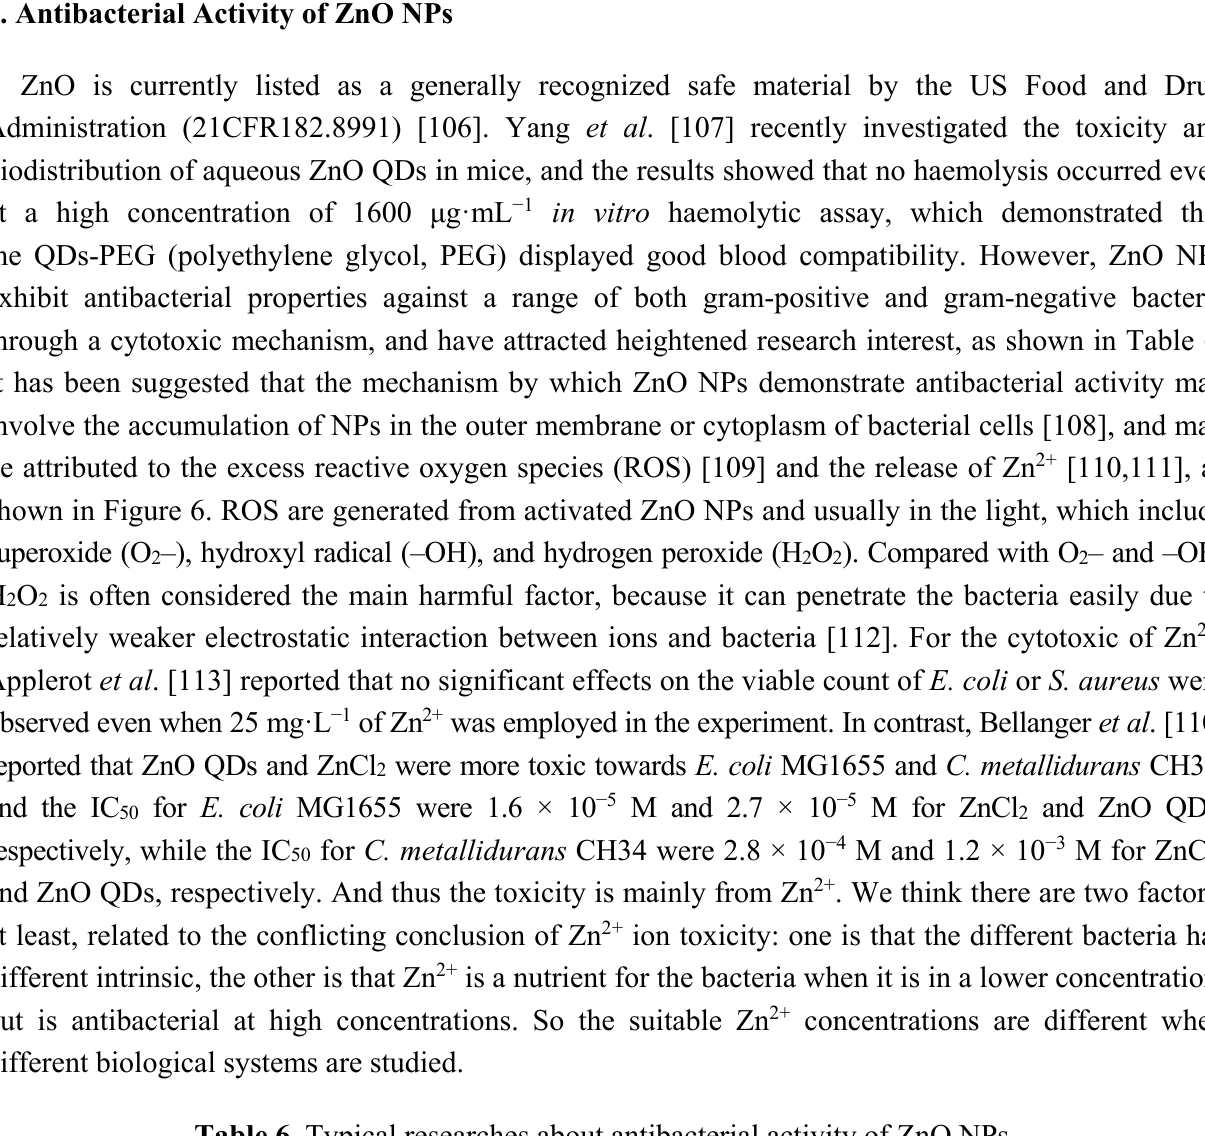
Table 6. Typical researches about antibacterial activity of ZnO